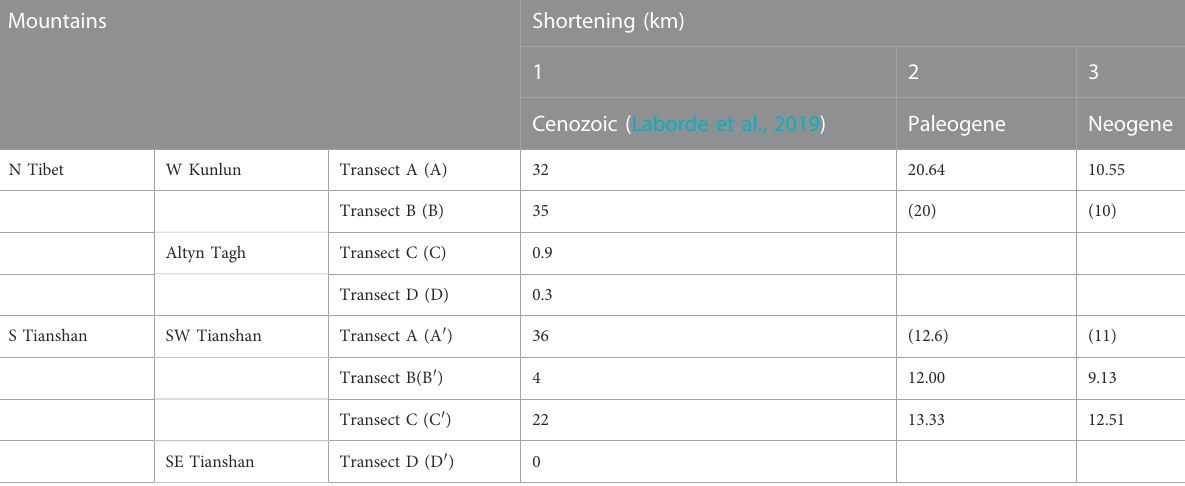
TABLE 2 Shortening estimates across the Tarim Basin and its periphery.